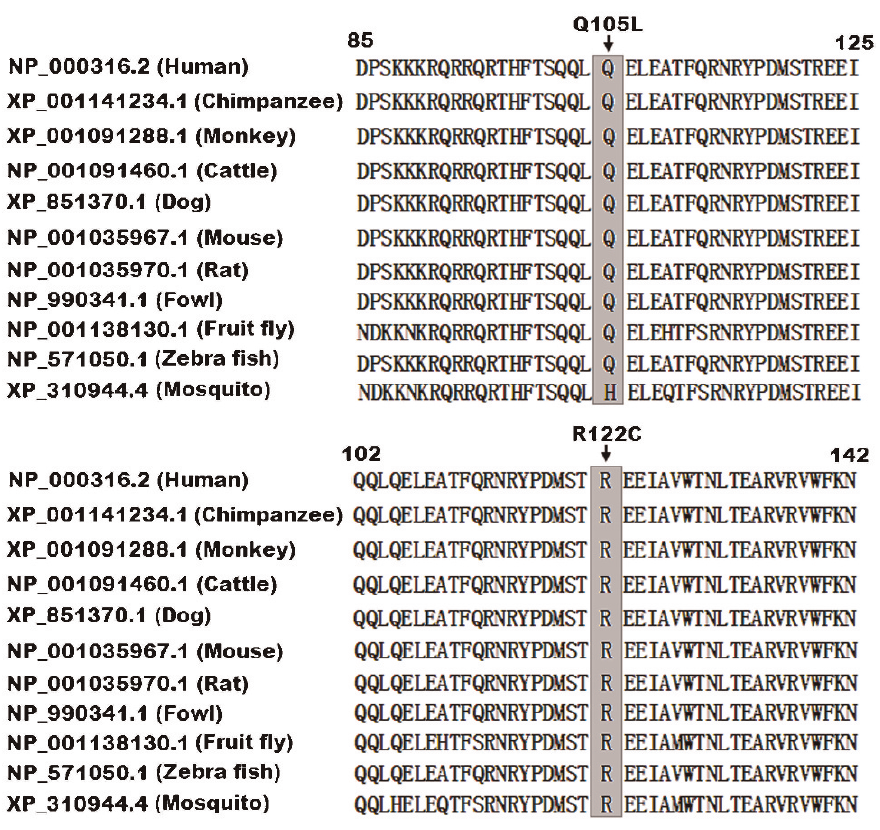
Figure 3 - Alignment of the multiple PITX2c protein sequences across species. The altered amino acids of p.Q105 and p.R122 are highly evolutionarily conserved among the various species.